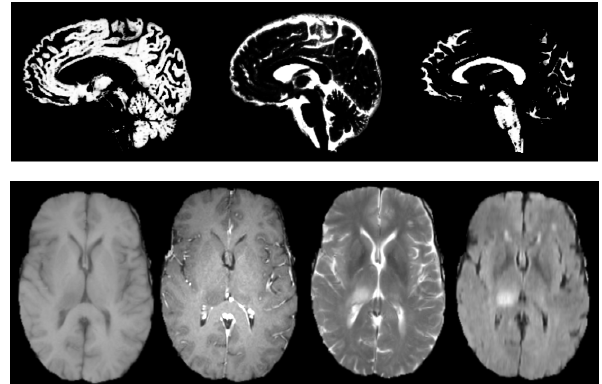
Figure 5. Slices from brain MRI volumes. This data are part of the ADHD200 consortium (the images above) [26] and BRATS 2017 challenge (the images below)